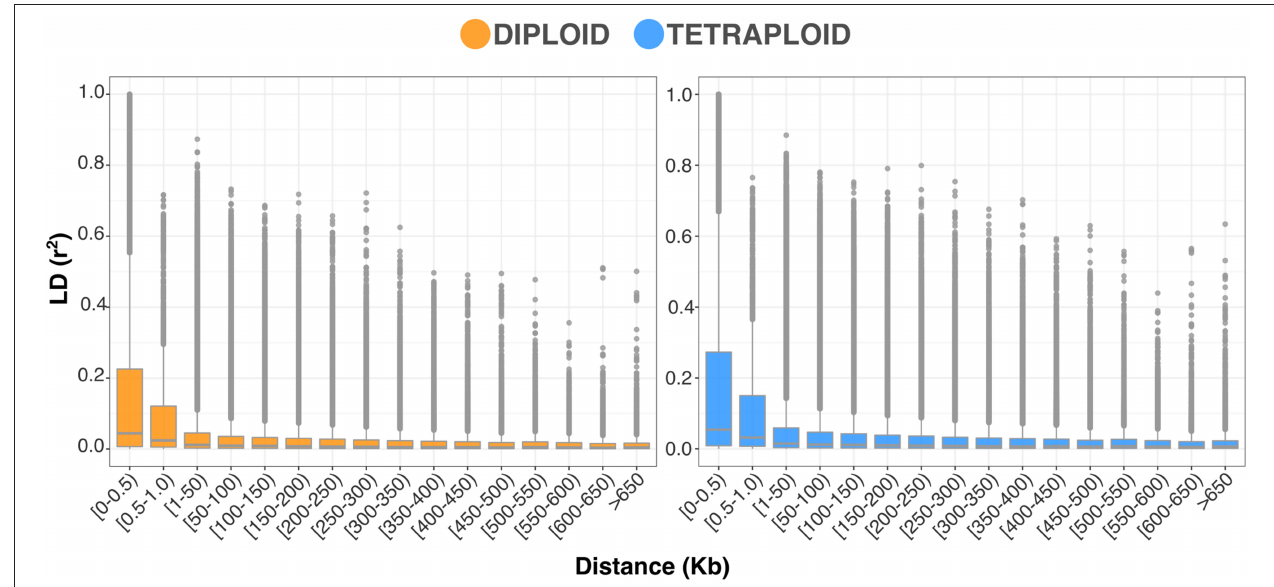
FIGURE 4 | Boxplots showing the trend of LD decay as a relationship between r 2 measures at different intervals of marker distances (Kb) for diploid and tetraploid standardizations.